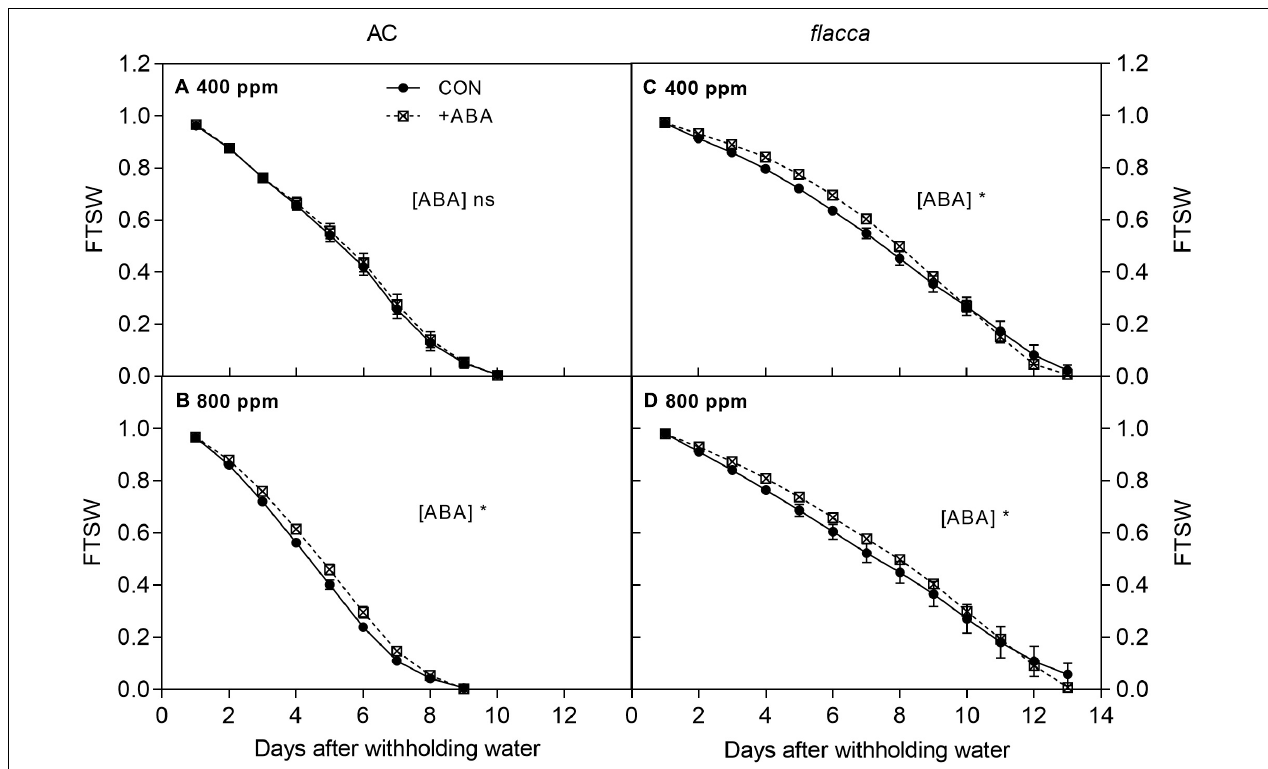
FIGURE 1 | Changes in the fraction of transpirable soil water (FTSW) in AC (A,B) and flacca (C,D) grown under ambient (400 ppm) and elevated (800 ppm) CO 2 concentrations during progressive soil drying. CON indicates the control treatment sprayed with water, +ABA indicates exogenous ABA application. Error bars indicate the standard error of the means (S.E.) ( N = 3–4). *Represents the significant differences among CON and +ABA treatments in ANCOVA (Days as a covariate) at p < 0.05; ns denotes no significant